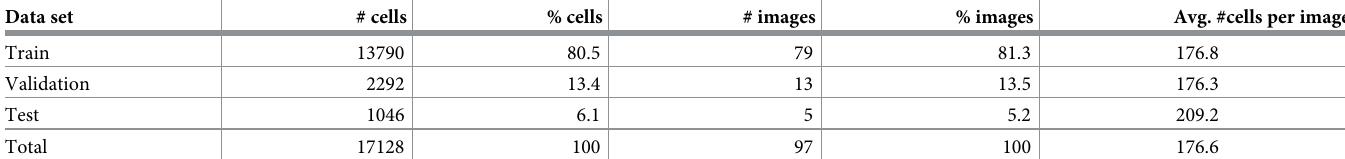
Table 3. Data set partitioning into training, validation and test data sets, considering the quantity of cells and the quantity of images. Data set # cells % cells # images % images Avg. #cells per image Train